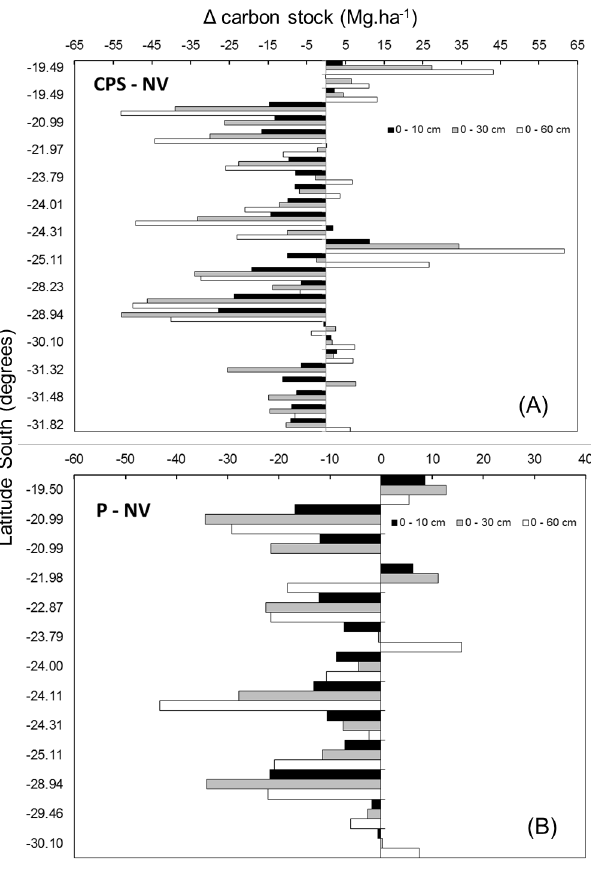
Fig. 3. Absolute difference of carbon soil stocks between different depth intervals: (A) crop-livestock systems (CPS) and native veg- etation (NV); and (B) pasture (P) and native vegetation (NV) at different paired study sites. Losses are indicated by a minus sign